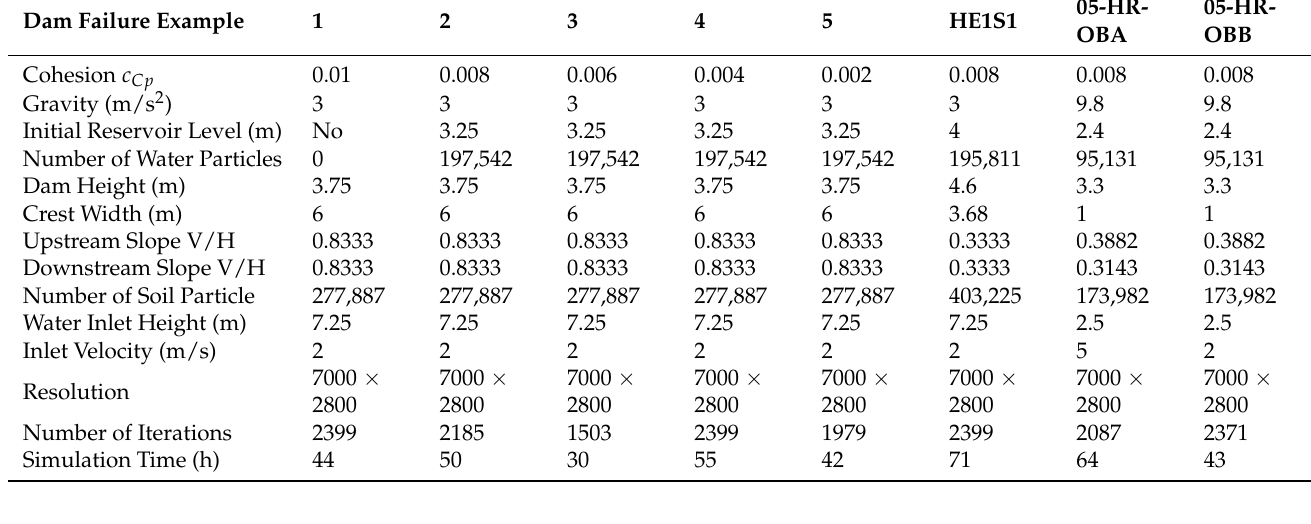
Table 2. Condition for the cohesive dam’s overtopping failure cases and simulation cases.